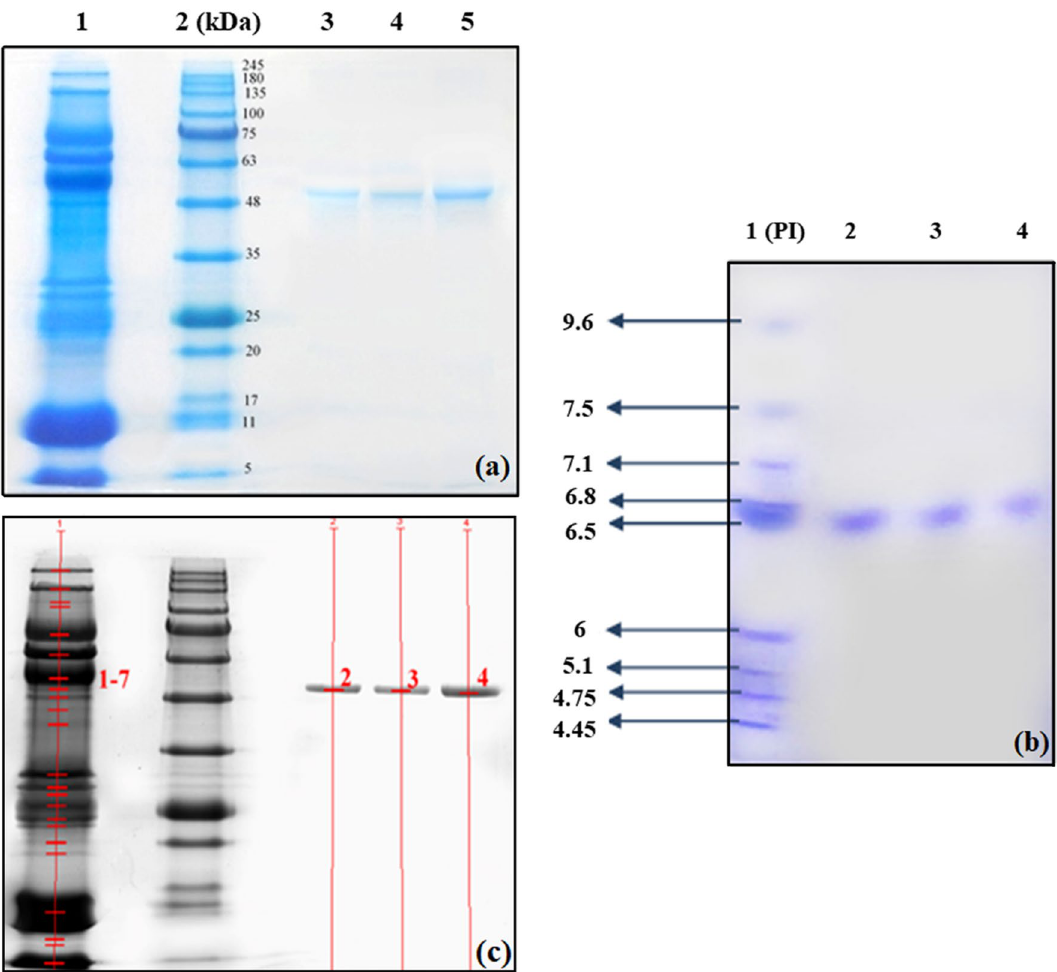
Figure 7. ( a ) SDS-PAGE analysis of: CFSM (lane 1), prestained protein ladder (BLUelf, cat no. PM008- 0500) (lane 2), the eluted samples from: magnetic Fe 3 O 4 @SiO 2 @CPTMS@DA (1) (lane 3), Fe3O 4 @SiO 2 @